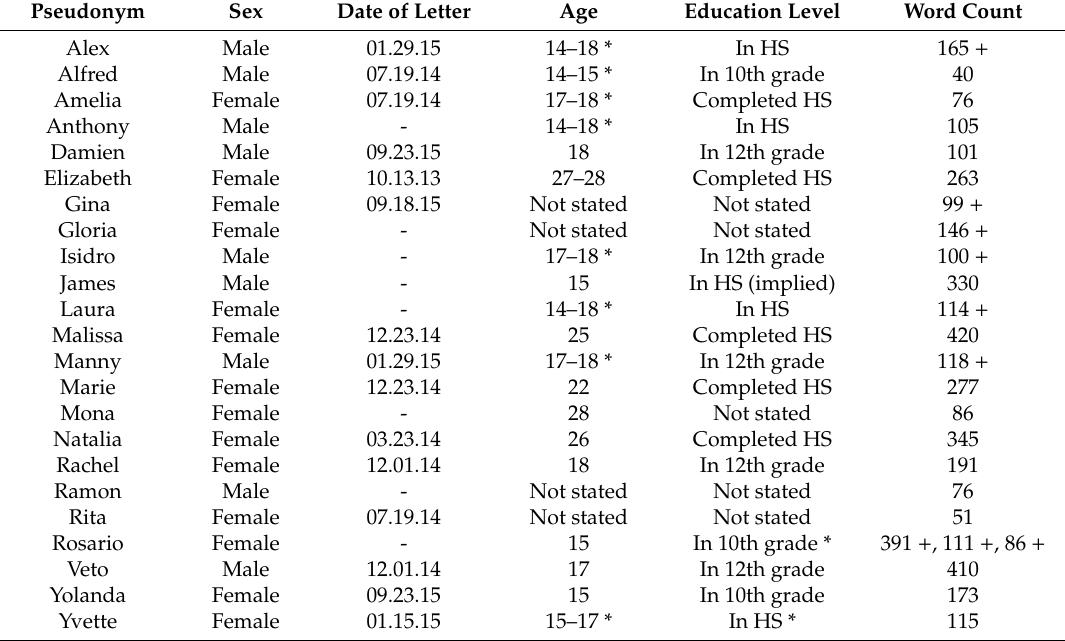
Table 1. Dreamers and letter